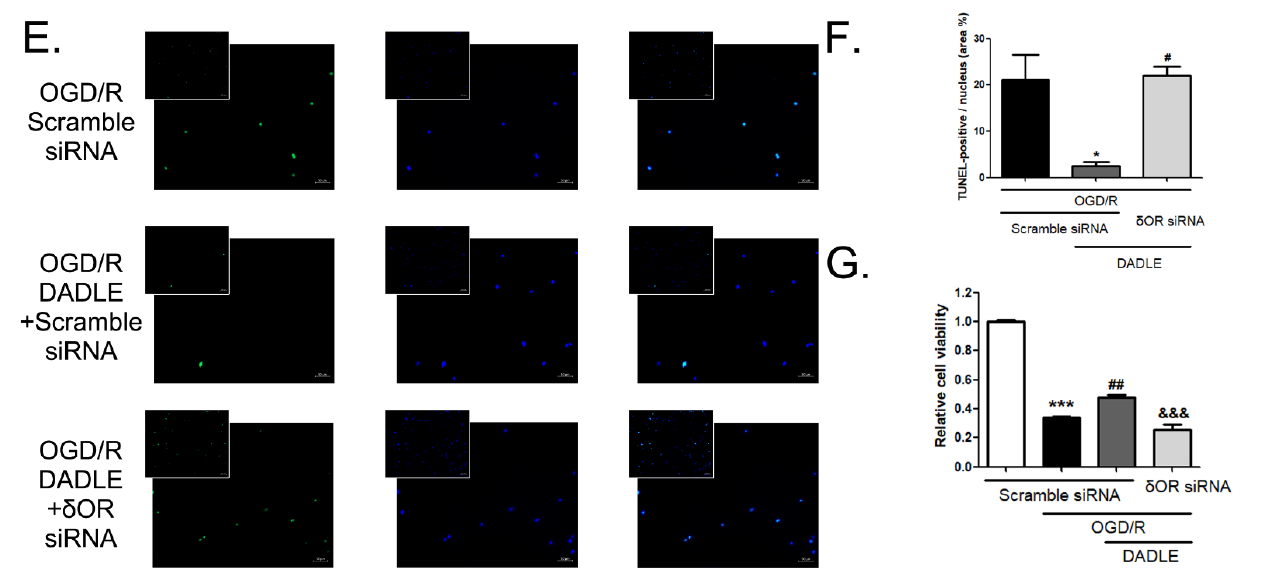
Figure 5. Both δOR antagonist NTI and interference of δOR can block DADLE-mediated decreased apoptosis in the OGD/R treated BMECs. ( A ) TUNEL staining detection of OGD/R-treated BMECs with 10 nM DADLE and an additional 1 μM NTI, and statistical analysis ( B ) showed the TUNEL- positive nuclei (as the area percentage of total nuclei), n = 4 or 5, ** p < 0.01 versus the control group; ## p < 0.01 versus the OGD/R + vehicle group; && p < 0.01 versus the OGD/R+DADLE group. TUNEL - positive cells were stained green. Nuclei were stained with DAPI and showed as blue. ( C ) CCK8 assay evaluated the relative cell viability of BMECs treated by 10 nM DADLE accompanied with 1 μM NTI after 12 h of OGD following 6 h reoxygenation. Data were normalized compared to the